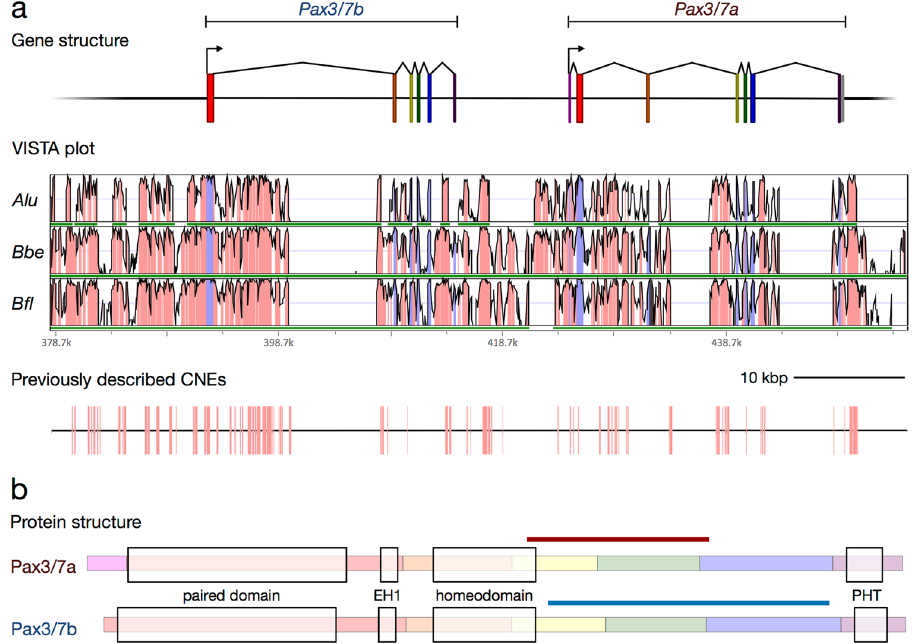
Figure 1. The structure and conservation of the cephalochordate Pax3/7 gene pair. ( a ) Gene models (top), VISTA plot (middle) and map of previously described B . floridae / A . lucayanum CNEs 36 (bottom) on the Branchiostoma lanceolatum scaffold. Alu = A . lucayanum ; Bbe = B . belcheri ; Bfl = B . floridae . In the VISTA plot, the horizontal axis indicates position on the B . lanceolatum genomic scaffold; green bars indicate coverage by the genome of the labelled species, and vertical axis indicates percent identity in a 45 bp rolling window, with a range of 50% to 100%. Pink colouration indicates regions exceeding the threshold of 90%, while blue indicates exonic sequence. Details of the scaffolds used in the VISTA analysis are reported in Supplementary Table S1. Scale bar = 10,000 base pairs. ( b ) Protein structure of the Pax3/7 genes in amphioxus. Each exon is highlighted with a colour corresponding with its colour in ( a ). Conserved domains are indicated with light boxes; the paired domain, the EH1 domain (also known as the Octapeptide motif or TN), the homeodomain, and the Paired- type Homeodomain Tail 45 . The positions of the paralogue-specific probes on the transcripts are marked with a coloured bar. An annotated sequence alignment is presented in Supplementary Fig.